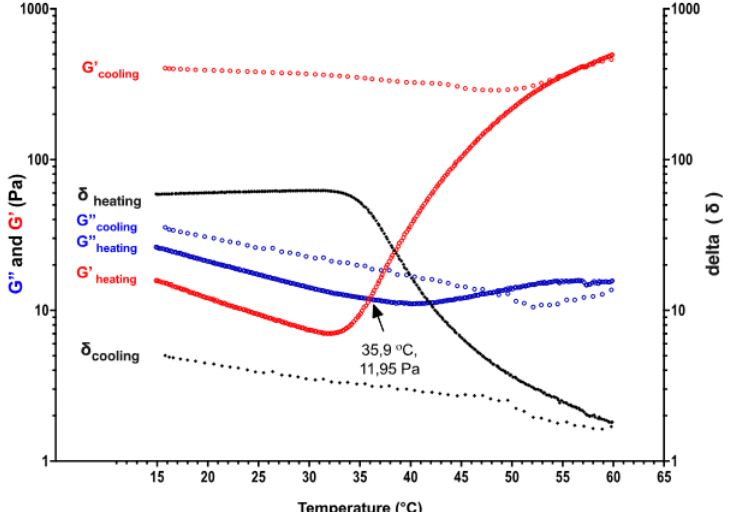
Figure 4. The gradient of viscous and elastic modulus of thermosensitive CS sol (initial concentration of CS solution 6% ( w / v ) neutralised by NaHCO 3 ) with temperature sweep between 15 – 60 °C during heating and cooling, respectively.